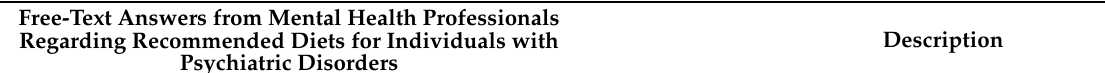
Table 3. List of free text answers by psychiatrists, psychologists, psychotherapists, and psychiatrists/psychologists in training regarding recommended diets for individuals with psychiatric disorders. Free-Text Answers from Mental Health Professionals Regarding Recommended Diets for Individuals with